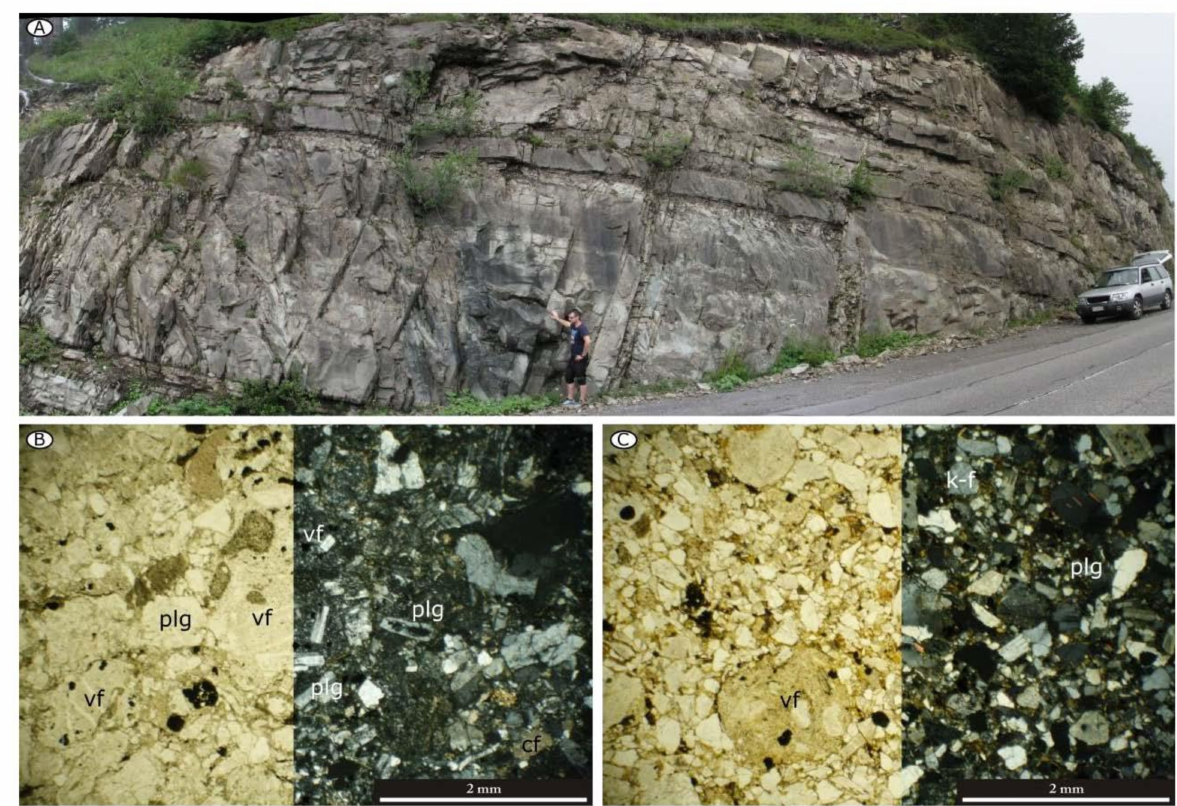
Figure 5. ( A ) A typical stratigraphic sequence of Taveyanne Sandstones in SE France, constituted of thick volcanogenic beds intercalated by thinner marly layers and nonvolcanic deposits. Dr. Crippa to scale. ( B ) Thin section of a syn-volcanic deposit, crossed nichols on the right. Large amounts of particles, plastically deformed, form a typical pseudomatrix and indicate short time between the production of detritus and its accumulation underwater. ( C ) Thin section of a postvolcanic deposit, crossed nichols on the right. The presence of rounded particles indicates that detritus underwent to erosion and transport before the underwater accumulation. All the photos are modified from [8]. Plg = plagioclase; k-f = k-feldspar; vf = volcanic rock fragment; cf = calcareous rock